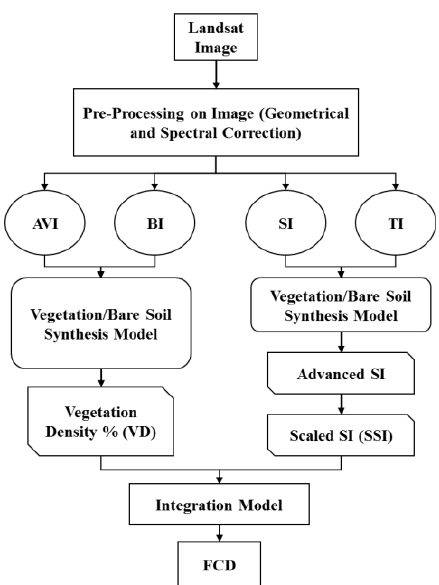
Figure 3. Methodological flow chart demonstrating di ff erent stages of the forest canopy density (FCD) model.